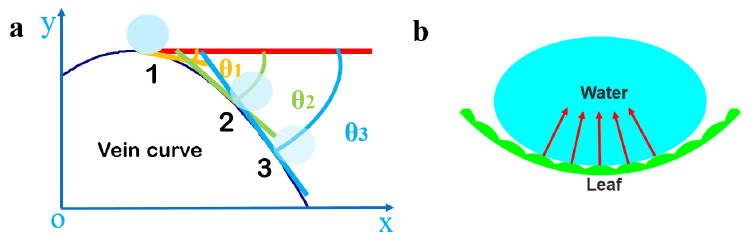
Figure 5. The schematic diagram of the influence of surface curvature on wettability. ( a ) In the direction parallel to the veins; ( b ) in the direction perpendicular to the veins.